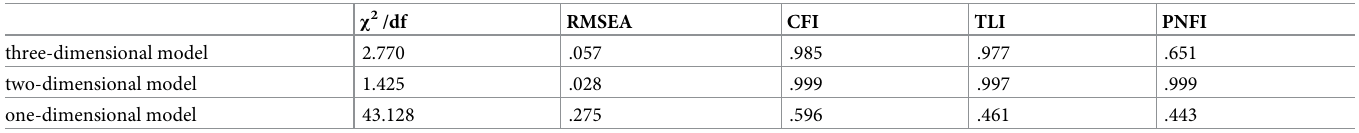
Table 2–2. Multidimensional dimension and single dimension fitting